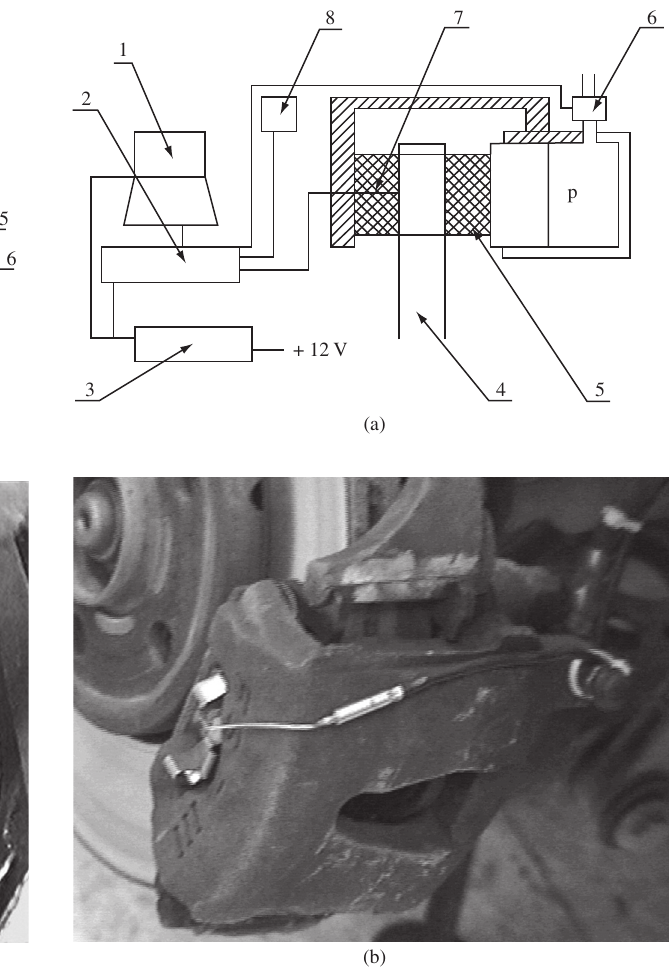
Figure 1. Pin-on-disc test machine: diagram a) 1-brake disc, 2-sample (fric- tion material), 3-thermocouple (J), 4-force sensor (HBM C2), 5-Spider 8 data acquisition device, 6- PC computer; and b) view of wear track.